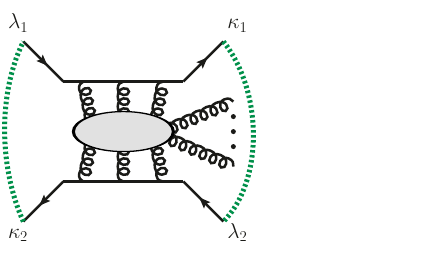
Figure 2 . Alternative contraction of ( D s (cid:0) 4)-dimensional spinor indices leading to a single trace. Indices connected by green dashed lines are traced